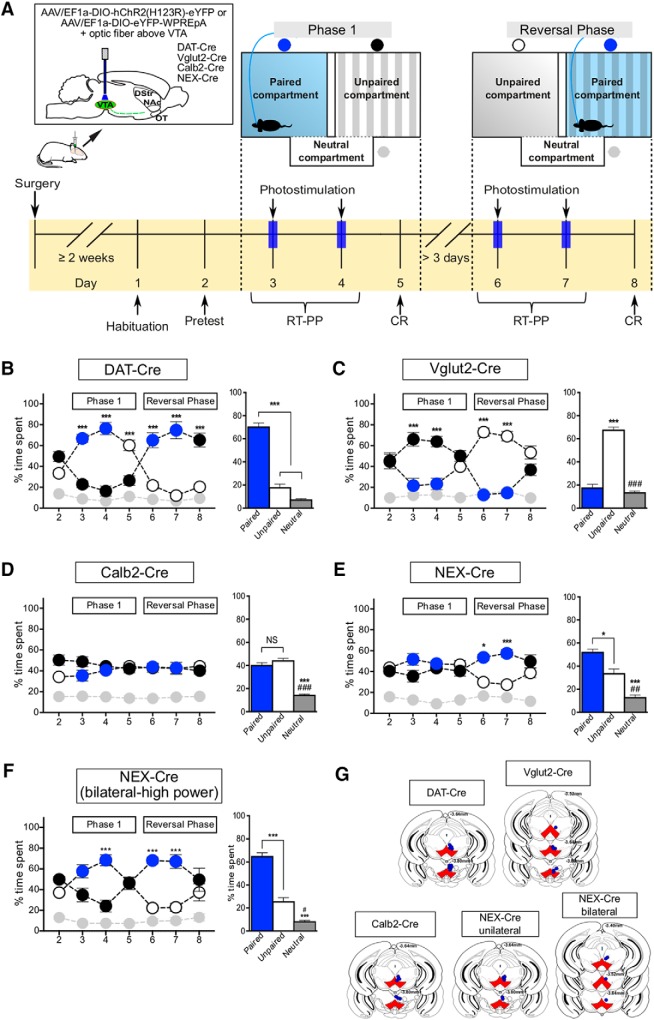
Optogenetic activation of NeuroD6 VTA neurons, but not Calb2 VTA neurons, induces place preference. A, Schematic drawing of stereotaxic injection into VTA of Cre-dependent DIO-ChR2-eYFP and of experimental setup for RT-PP analysis. B–F, Time spent in light-paired (blue), unpaired (white during phase 1, black during reversal phase), and neutral (gray) compartments shown as mean percentage of time spent in each compartment ± SEM (left; *p < 0.05, ***p < 0.001 paired vs unpaired compartment); average percentage of time spent in each compartment during days 3, 4, 6, and 7 ± SEM (bar graphs; right; *p < 0.05, ***p < 0.001 vs light-paired compartment; #p < 0.05, ##p < 0.01, ###p < 0.001 vs unpaired compartment). DAT-Cre N = 10; Vglut2-Cre N = 7; Calb2-Cre N = 7; NEX-Cre N = 5. F, High-power stimulation of bilaterally injected NEX-Cre mice (N = 4). G, Schematic illustration of optical fiber placement in mice analyzed in RT-PP analysis. NS, non-significant. DAT, Dopamine transporter; Calb2, Calbindin 2 (Calretinin); NEX, NeuroD6; Vglut2; Vesicular glutamate transporter 2; ChR2; Channelrhodopsin 2; eYFP, enhanced Yellow fluorescent protein.